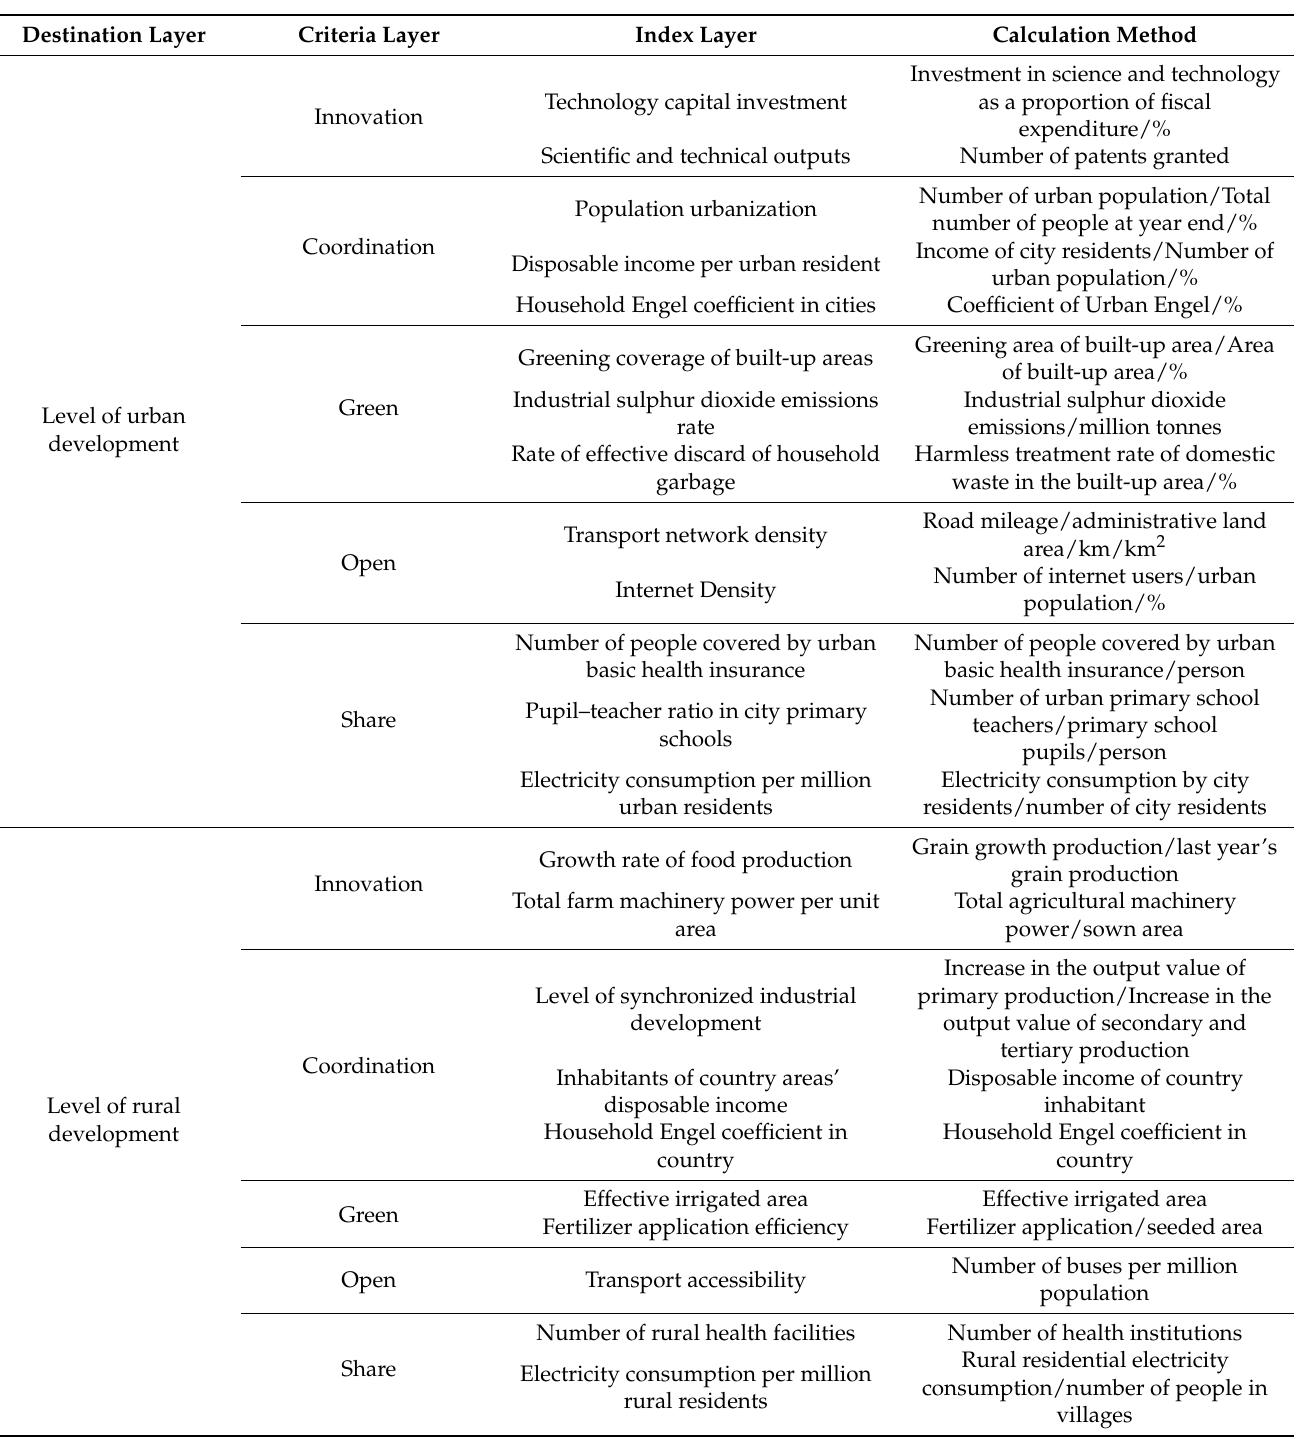
Table 1. Urban–rural integration and indicator